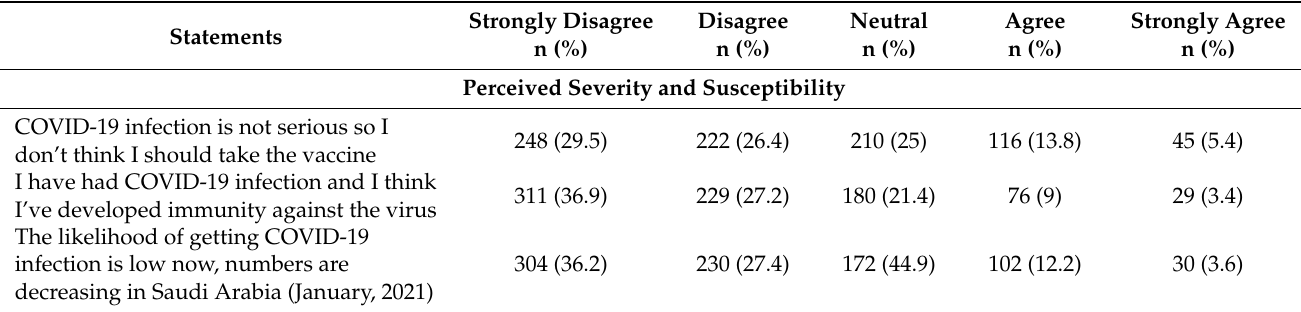
Table 2. Perceptions severity and likelihood of COVID-19